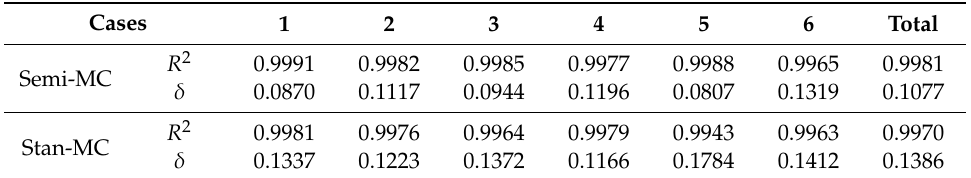
Figure 3. Lidar signals calculated by the analytical model, semi-MC and stan-MC algorithms in inhomogeneous water when the peak depths of the layer z L are ( a ) 5 m (Cases 1–2 in Table 3), ( b ) 10 m (Cases 3–4 in Table 3) and ( c ) 15 m (Cases 5–6 in Table 3). Table 4. The R 2 and δ of the analytical model compared with the semi-analytic and standard MC algorithms according to Figure 3.